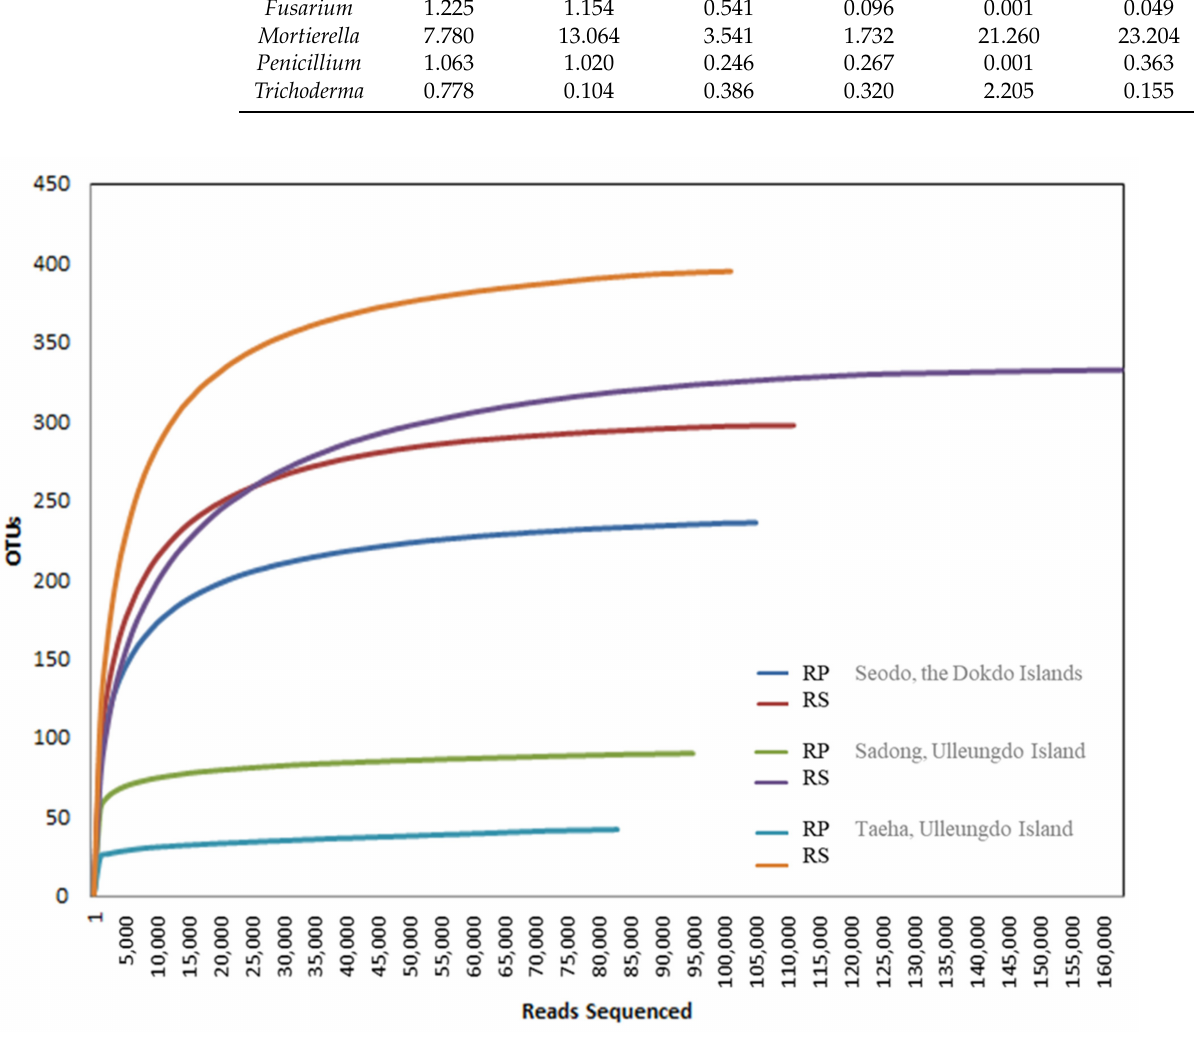
Figure 4. Illumina MiSeq sequencing rarefaction curve for operational taxonomic units (OTUs) from each site. OTUs were clustered at 3% dissimilarity using CD-HIT. The microbial community in the RP and the RS of Seodo, the Dokdo Islands (OTUs, 140/341; sequencing reads, 84,267/94,745), Sadong, coastline of Ulleungdo Island (OTUs, 154/389; sequencing reads, 95,395/117,939), and Taeha, inland of Ulleungdo Island (OTUs, 212/478; sequencing reads, 86,299/89,864), are